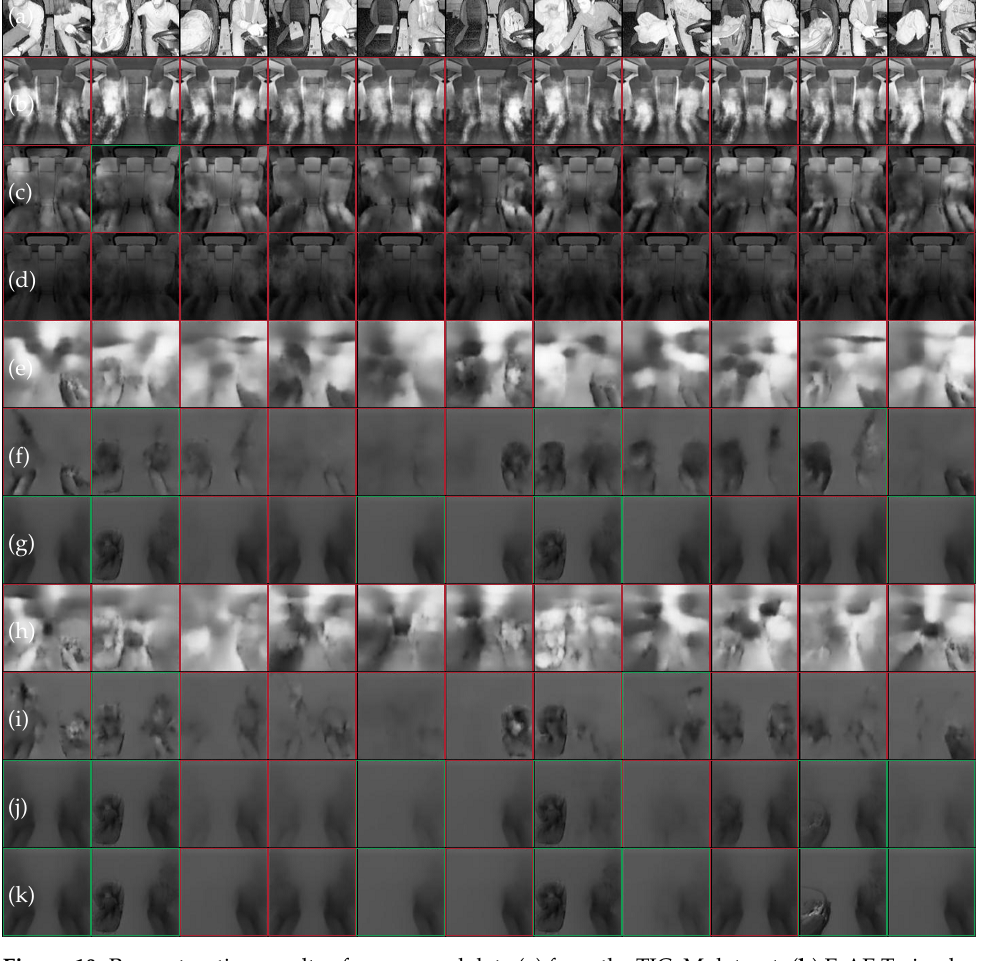
Figure 10. Reconstruction results of unseen real data ( a ) from the TICaM dataset: ( b ) E-AE Trained on Tesla SVIRO, ( c ) E-AE Trained on Kodiaq SVIRO-Illumination , ( d ) I-E-AE Trained on Kodiaq SVIRO- Illumination , ( e ) E-AE, ( f ) I-E-AE, ( g ) II-E-AE, ( h ) E-TAE, ( i ) I-E-TAE, ( j ) II-E-TAE and ( k ) Nearest neighbour of ( j ). Examples ( e – k ) are all trained on our new dataset. A red (wrong) or green (correct) box highlights whether the semantics are preserved by the